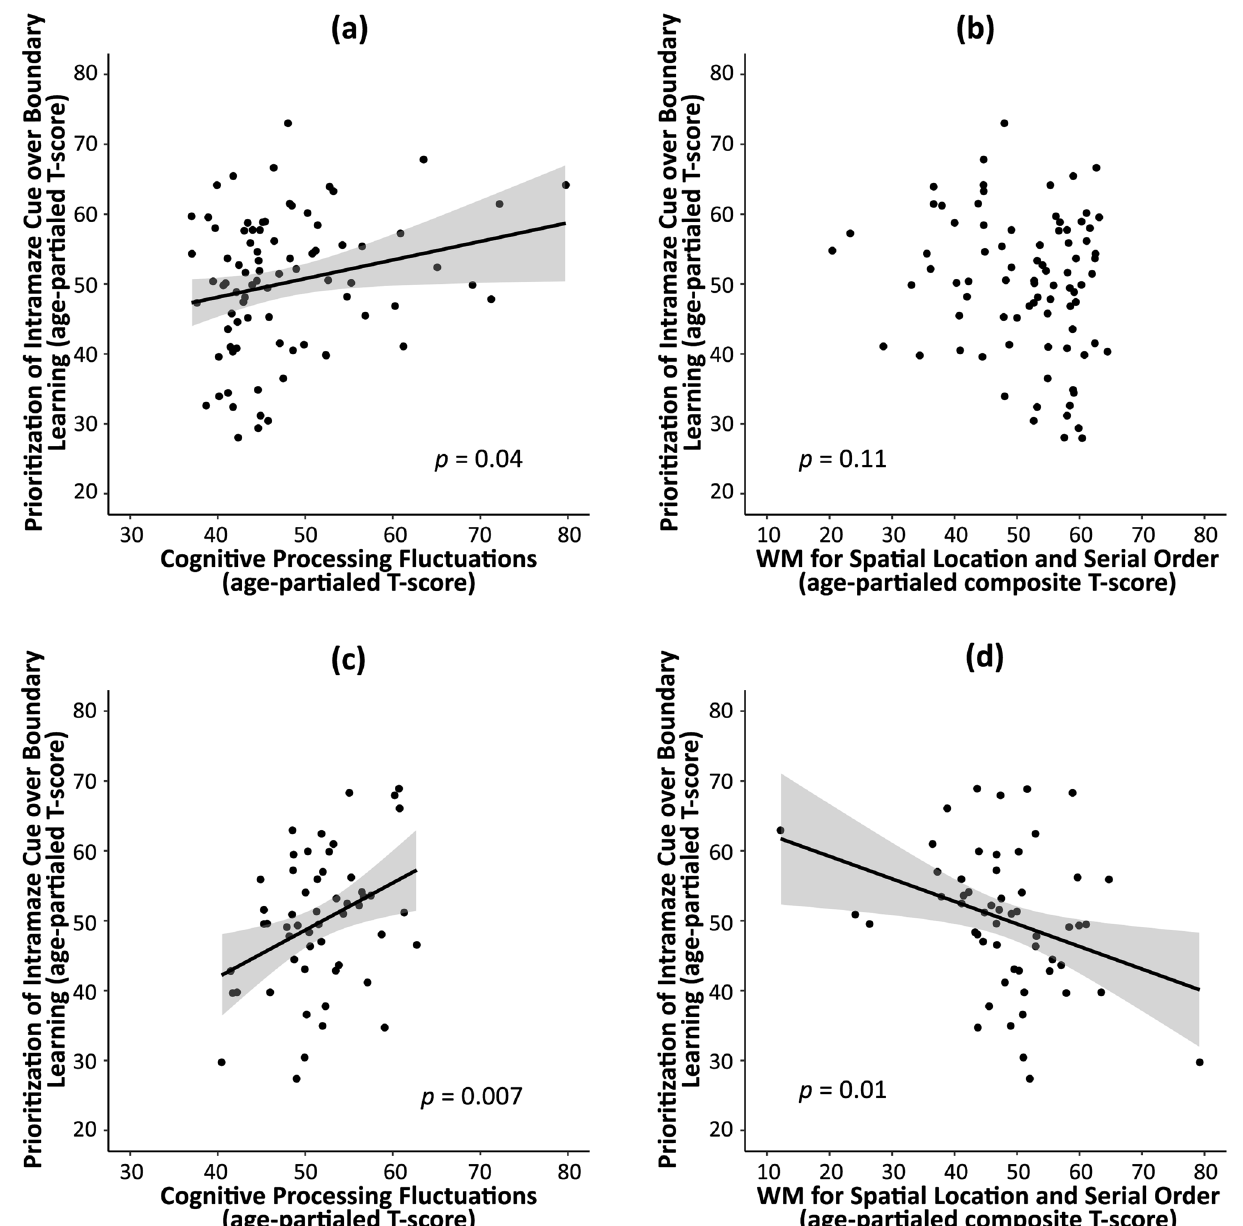
Figure 3. Scatterplots of the bivariate Pearson’s product moment correlations for the child development subsample (panels a , b ) and adult development subsample (panels c , d ). Shown are correlation between cognitive processing fluctuations (panels a , c ) or spatial working memory capacity (panels b,d) and the relative prioritization of intramaze cue-based over boundary-based learning. The gray areas around the linear regression lines represent the 95% confidence intervals of the linear model